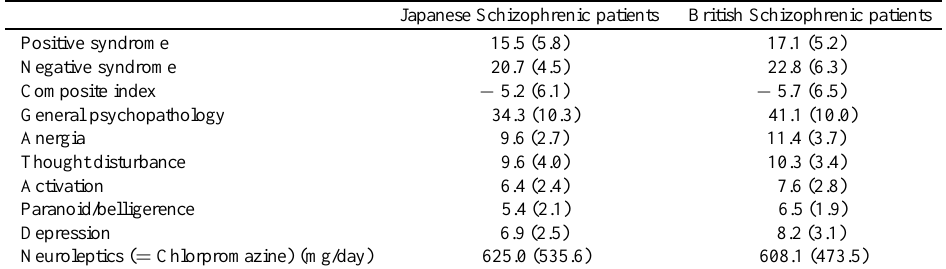
Table 2 The symptoms rated by Positive and Negative Syndrome Scale [25] and the neuroleptic dose of chlorpromazine equivalents in the Japanese and British schizophrenic patients. (means and, in parenthesis, standard deviations)